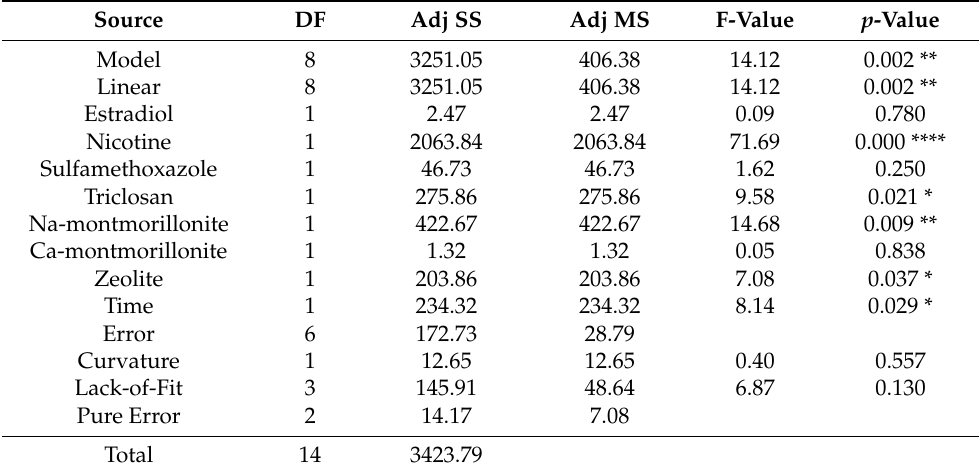
Figure 2. Standardized effect in a normal graph and a Pareto chart of the factors in estradiol removal. A: estradiol, B: nicotine, C: sulfamethoxazole, D: triclosan, E: Na-montmorillonite, F: Ca-montmorillonite, G: Zeolite, and H: Time. Table 6. ANOVA of the experimental design performed to assess estradiol removal with